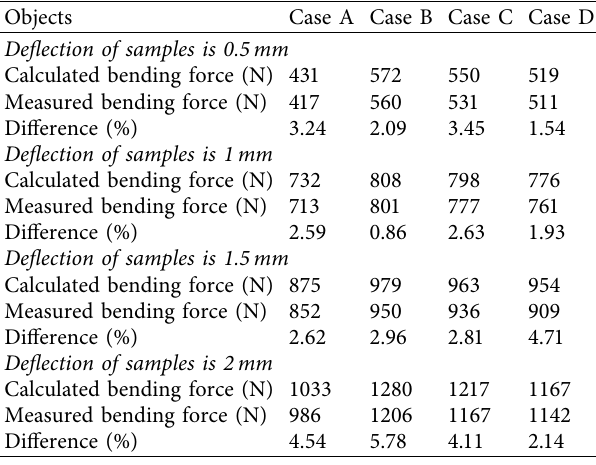
Table 14: Comparison of results of mechanical bend tests and computational